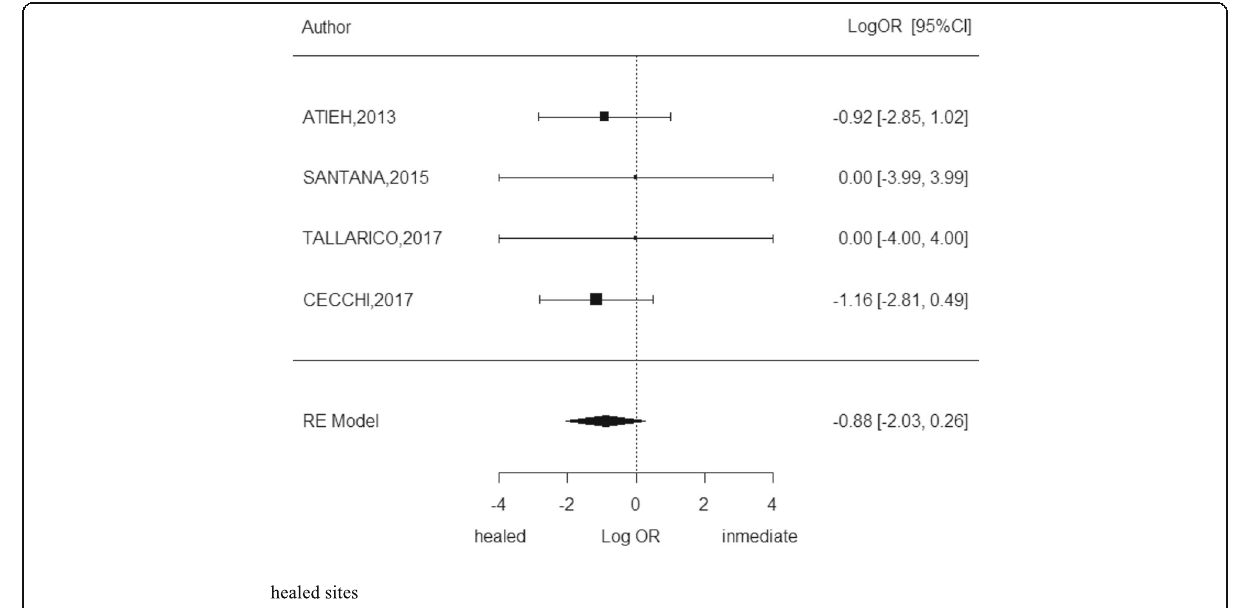
Fig. 7 Meta-analysis of implant survival rate between immediate and conventional implants